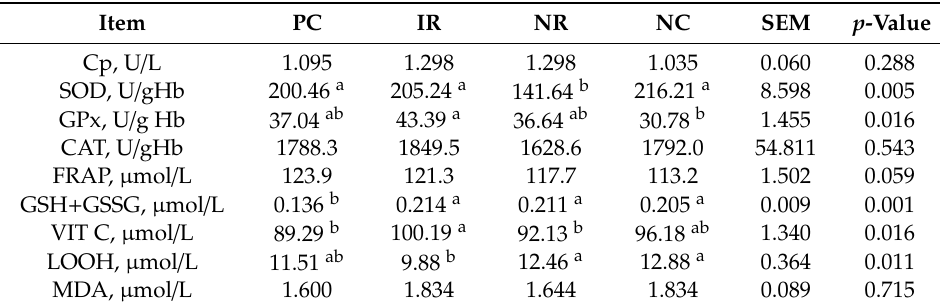
Table 6. Indicators of redox status in turkey blood.